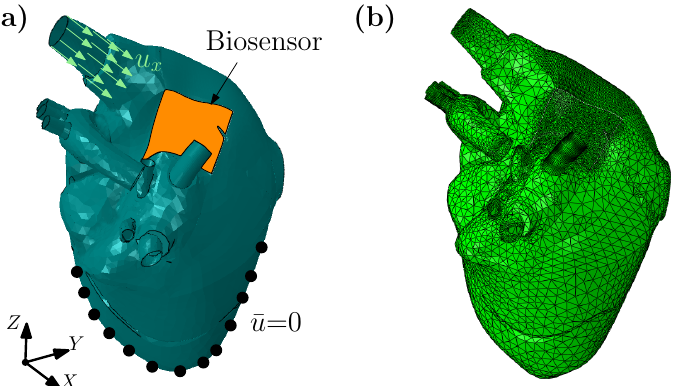
Figure 4. Fracture of a biosensor attached to the heart. ( a ) Geometric dimensions and boundary conditions of a heart model. ( b ) Mesh model of